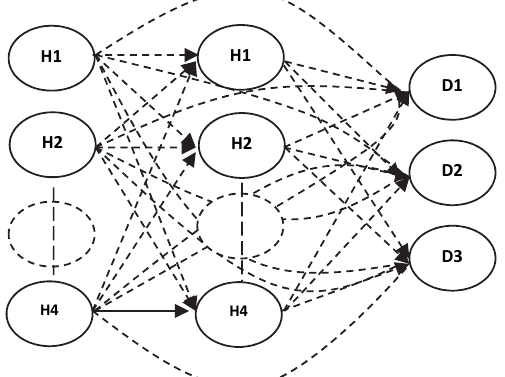
Fig.2. A transshipment network for